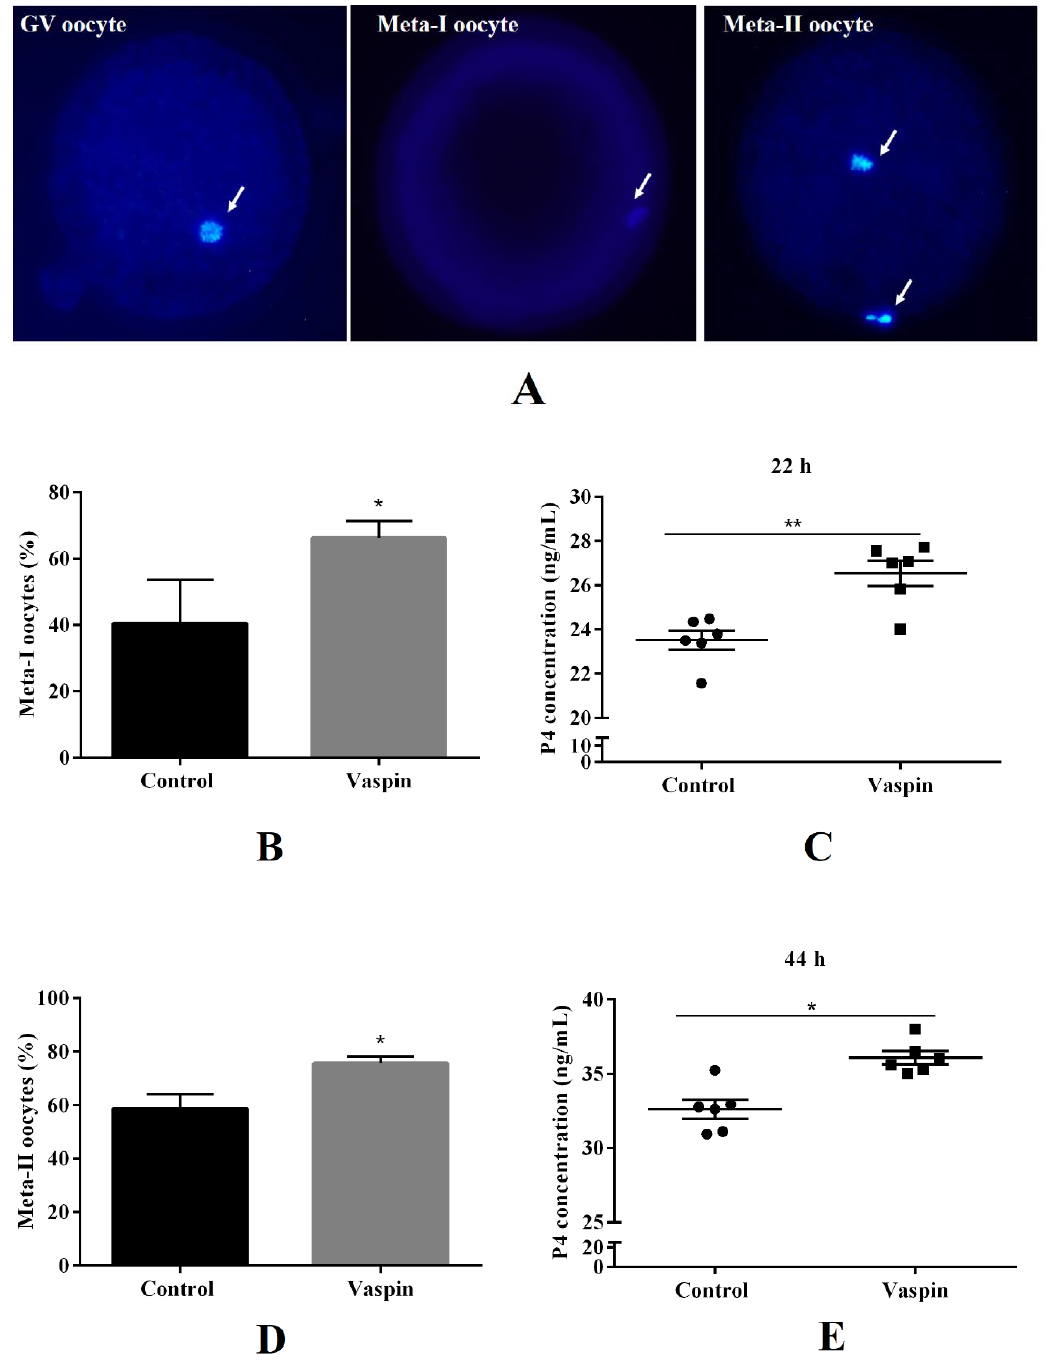
Figure 2. E ff ect of vaspin on nuclear oocyte maturation and progesterone (P4) secretion. COCs (30 / group / experiment) were selected after morphological examination of material collected from the ovaries taken from 100 pigs (15 follicles / ovary). Porcine cumulus–oocyte complexes (COCs) were cultured for 22 h or 44 h in maturation medium in the presence or absence of vaspin (1 ng/mL) then mechanically separated into oocytes and cumulus cells. Nuclear maturation stages ( A ) were analysed by Hoechst 33342 or DAPI staining ( B , D ), while medium was collected and P4 levels measured by ELISA ( C , E ). DNA content shown by arrows. Experiments were performed independently and repeated three times ( n = 3). Data are plotted as the mean ± SEM of three independent experiments. Significance between control and vaspin group is indicated by * p < 0 . 05 and ** p < 0 . 01; GV (germinal vehicle stage), metaphase-I of meiosis (meta-I), metaphase-II of meiosis (meta-II).